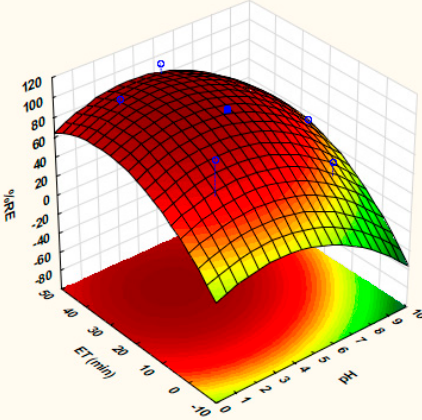
Figure 2. 3-D Response surface plot for the %removal efficiency of As onto MWCNT-Fe 3 O 4 @Zeo nanocomposite: Effect of sample pH and extraction time (ET)when the mass of adsorbent fixed at 125 mg.